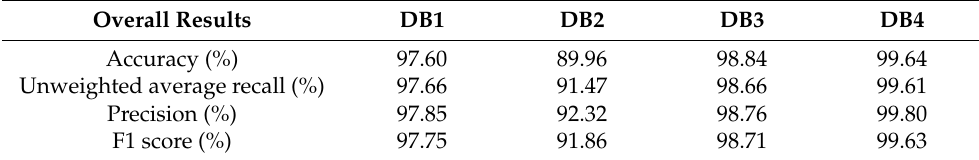
Table 7. Overall results (%) obtained using our proposed model using four databases.